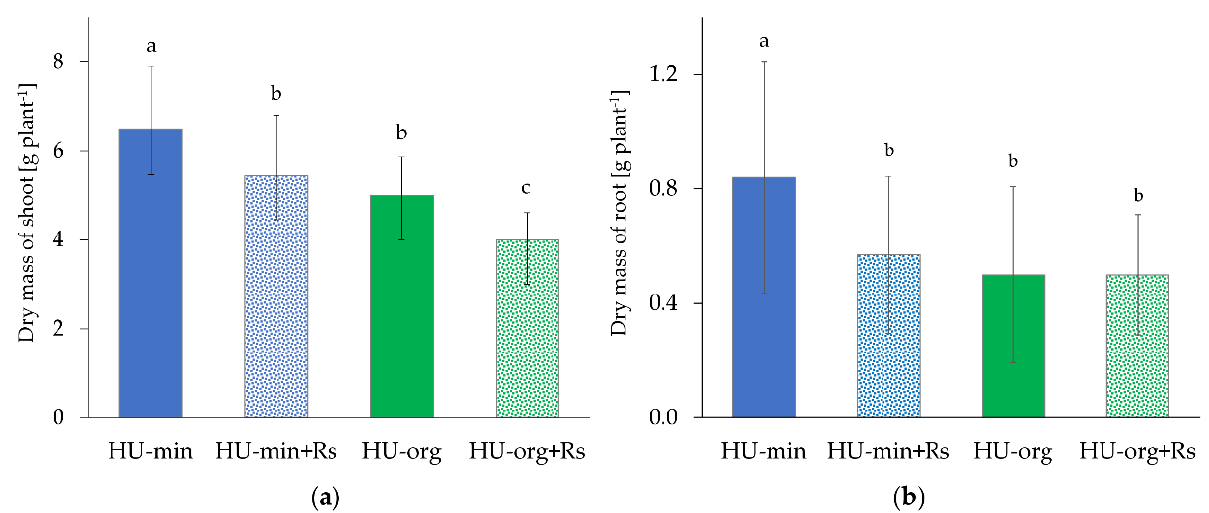
Figure 1. Influence of long-term mineral (HU-min) and organic (HU-org) fertilization and presence of the pathogen Rhizoctonia solani AG1-IB (+Rs) on shoot ( a ) and root ( b ) dry masses of lettuce (cv. Tizian) grown under controlled growth chamber conditions. Different letters indicate significant differences according to linear mixed model analysis ( p < 0.05).